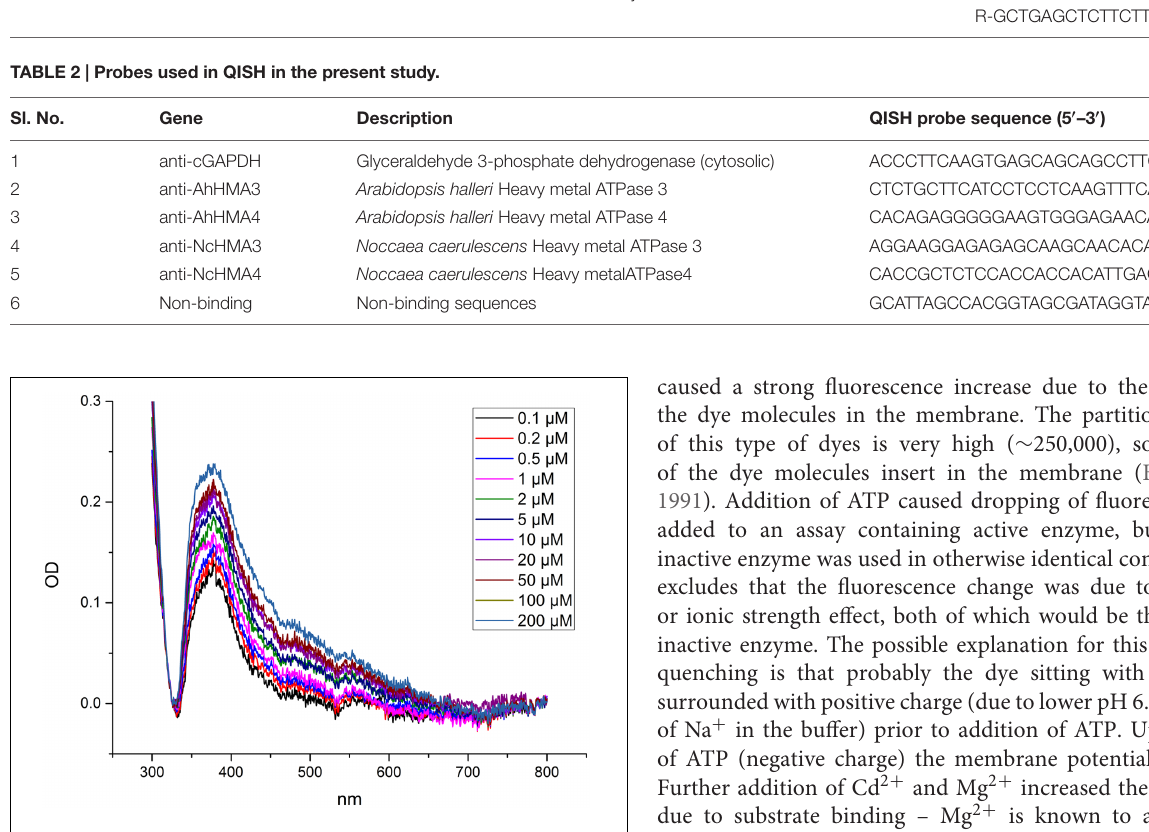
FIGURE 1 | Measurement of metal binding to NcHMA4 protein through ligand-metal charge transfer (LMCT) spectra. Difference spectra showing absorption changes of NcHMA4 in response to the addition of increasing amounts of Cd 2 + . The 100 µ l protein containing approximately 0.6–0.7 µ g/ml protein was titrated by 0.1–200 µ M Cd 2 + final concentration. The figure is representative for two independent